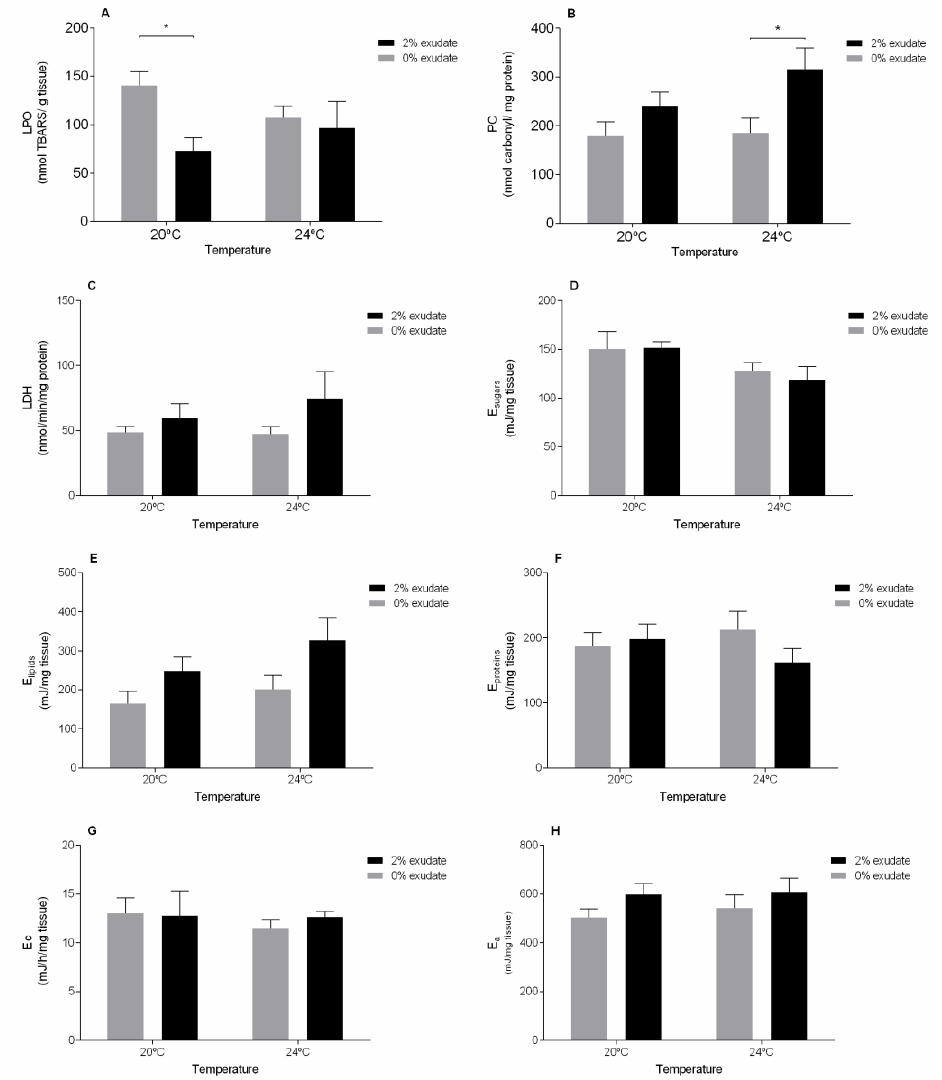
Figure 3. Biochemical biomarker responses of M. galloprovincialis muscle after 96 h of exposure to A. armata exudate at different temperatures. ( A ) Lipid peroxidation (LPO), ( B ) protein carbonylation (PC), ( C ) lactate dehydrogenase (LDH), ( D ) sugar content (E sugar ), ( E ) lipid content (E lipids ), ( F ) protein content (E proteins ), ( G ) energy consumption (Ec), and ( H ) energy available. Asterisk (*) indicates a significant difference compared with the 0% and 2% of A. armata exudate from the same temperature.